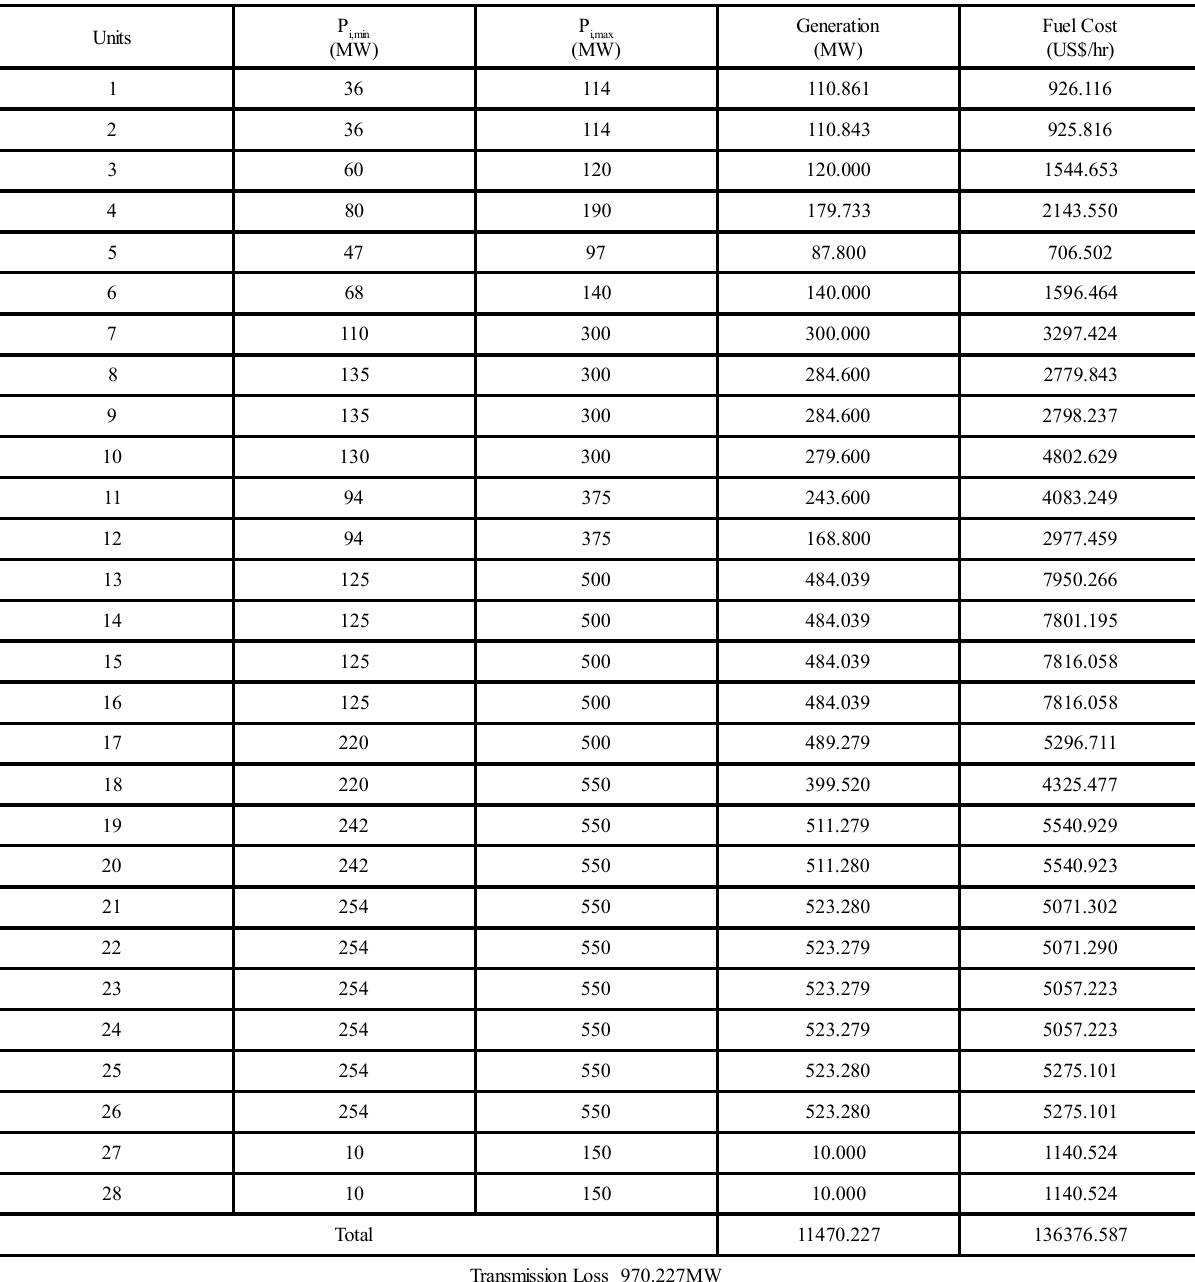
TABLE 5. OPTIMAL GENERATION AND COST (40 UNITS TEST